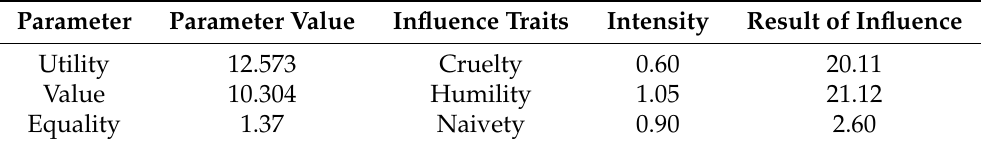
Table 14. Calculation of the influence of the parameters of satisfaction with the traits in order with the thresholds λ , β , and ε .